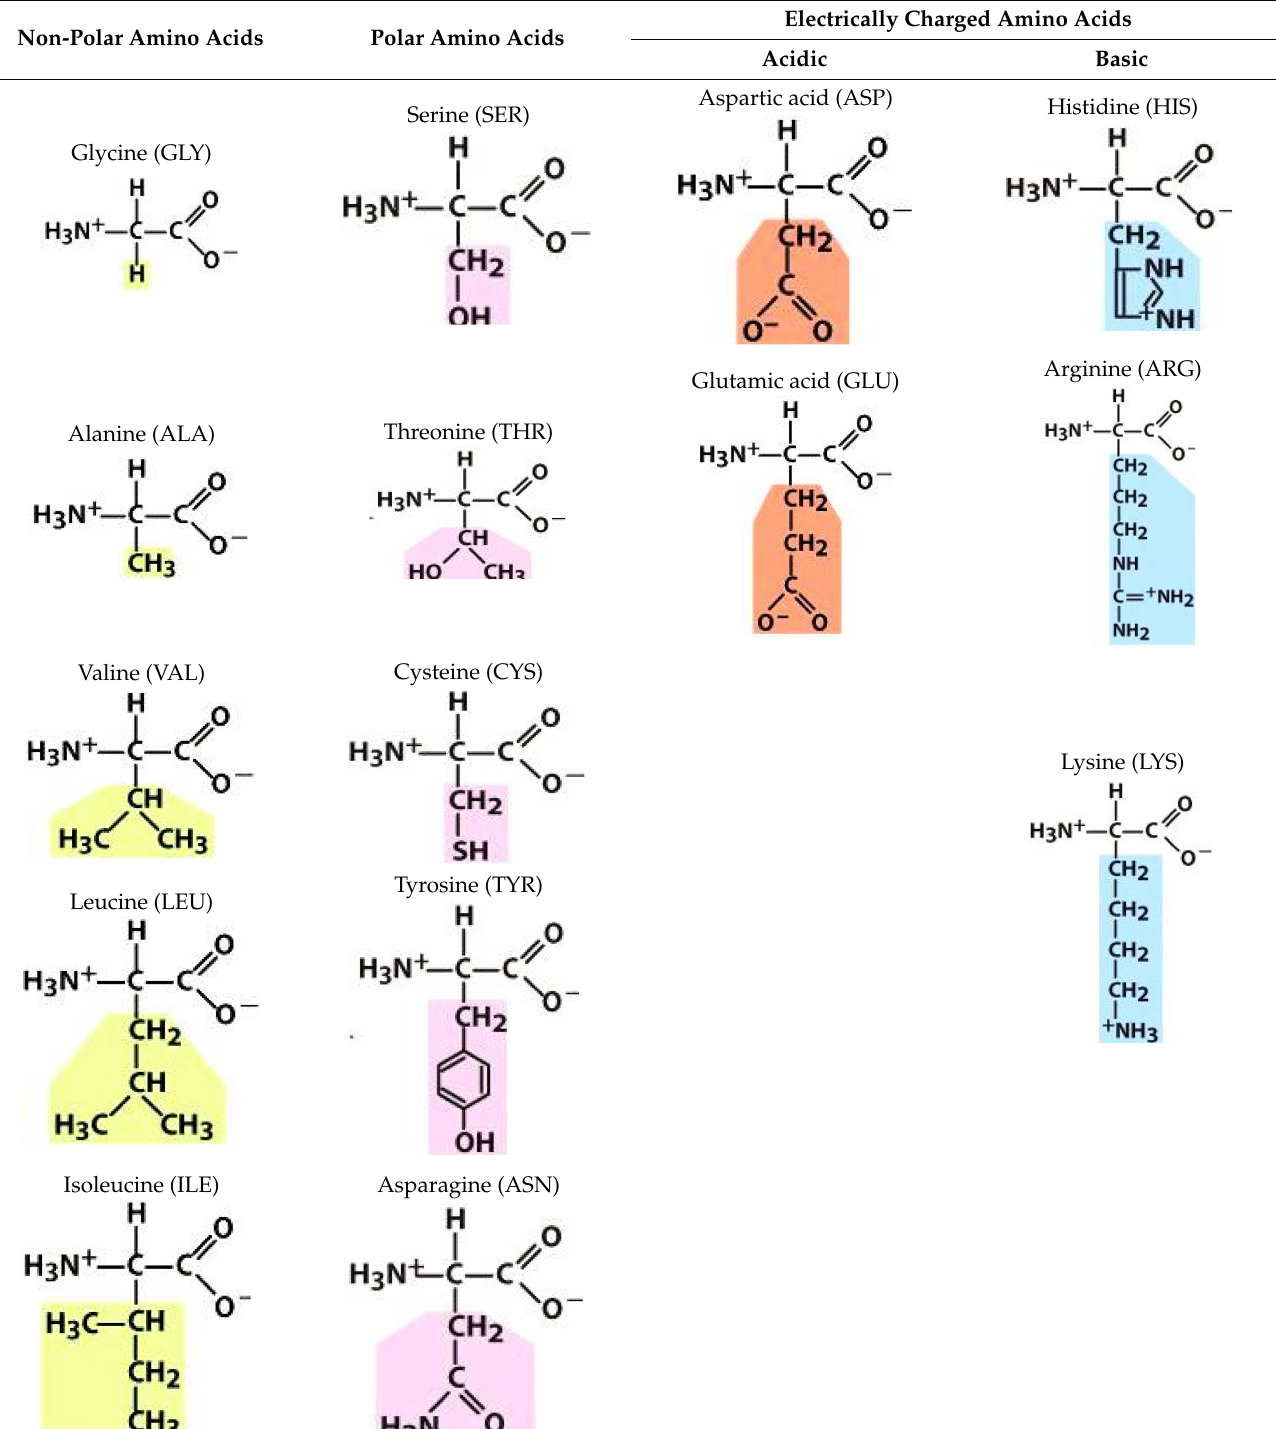
Table 1. Amino acid classification based on their side chains